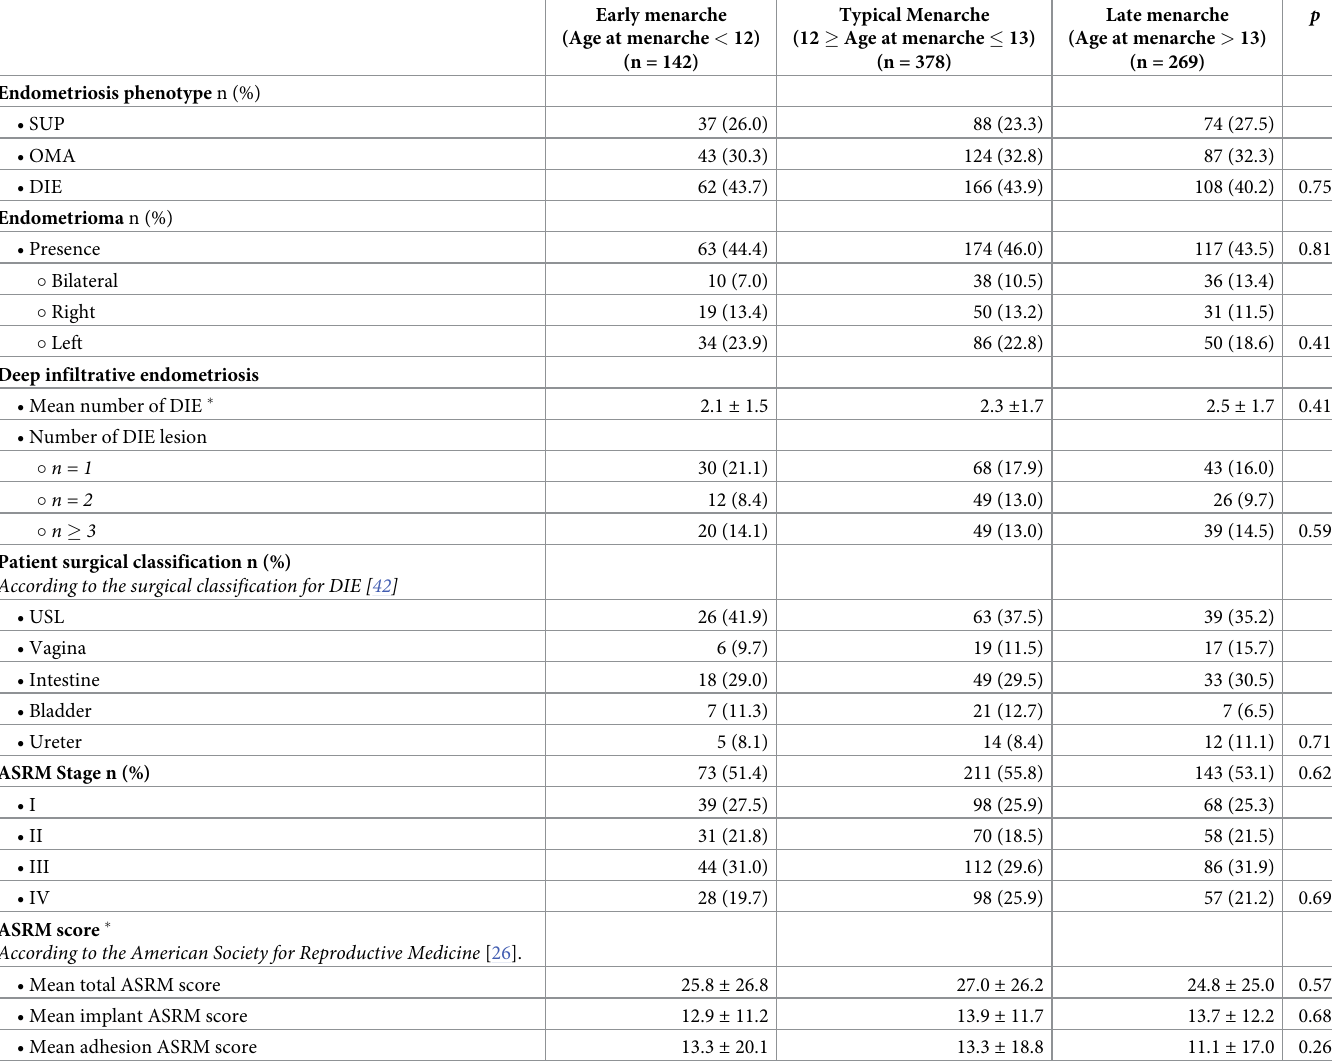
Table 2. Comparison of the disease phenotypes and the anatomical distribution of the lesions of 789 patients at first surgery for endometriosis, according to early, typical, or late menarche.